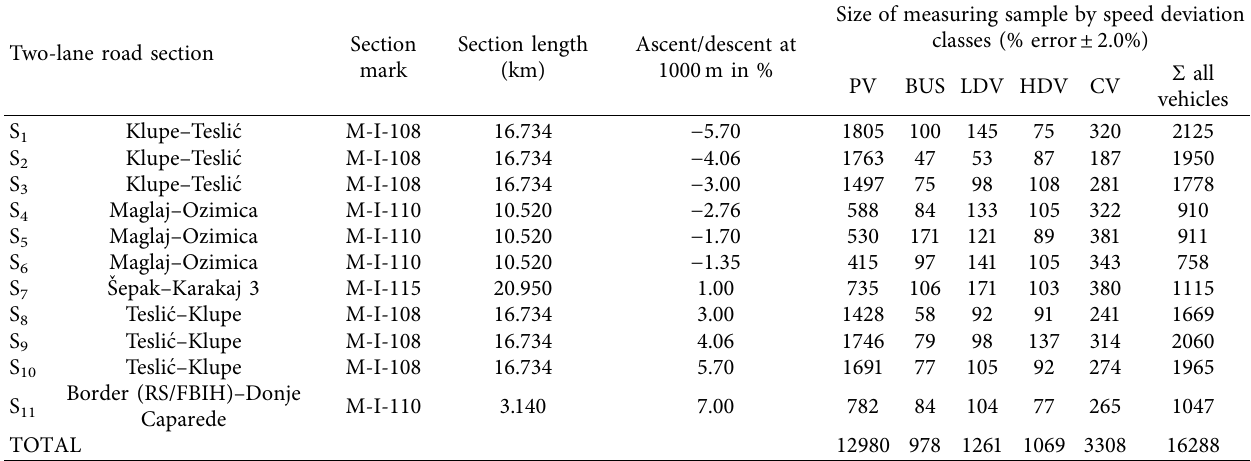
Table 5: Determined value of measuring sample according to vehicle classes. Two-lane road